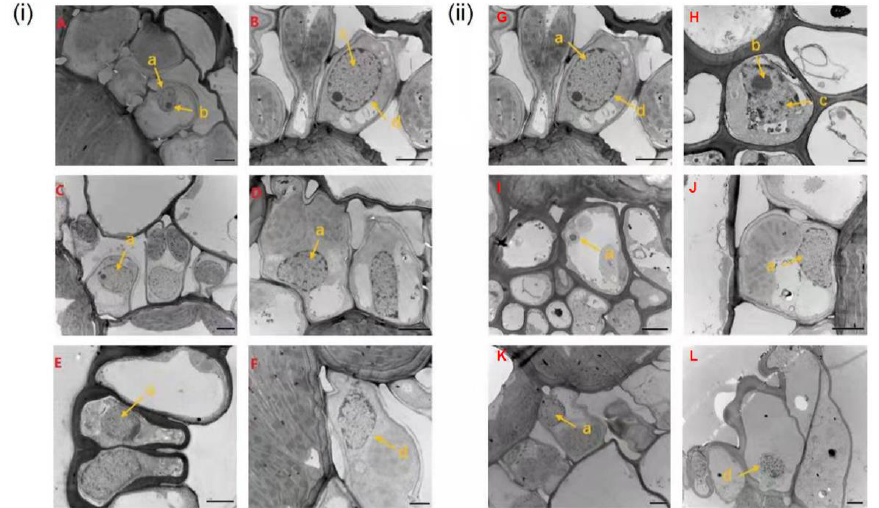
Figure 5. Changes in the nuclei of rust-resistant Z. japonica (RR) and rust-susceptible Z. japonica (RS) after inoculation with P. zoysiae . ( i ) Inoculated RR leaves; ( ii ) Inoculated RS leaves; ( A , G ) Non-inoculation; ( B , H ) 5 day post inoculation (dpi); ( C , I ) 8 dpi; ( D , J ) 10 dpi; ( E , K ) 15 dpi; ( F , L ) 20 dpi. (a) nucleus; (b) nucleolus; (c) nuclear matrix; (d) nuclear membrane.